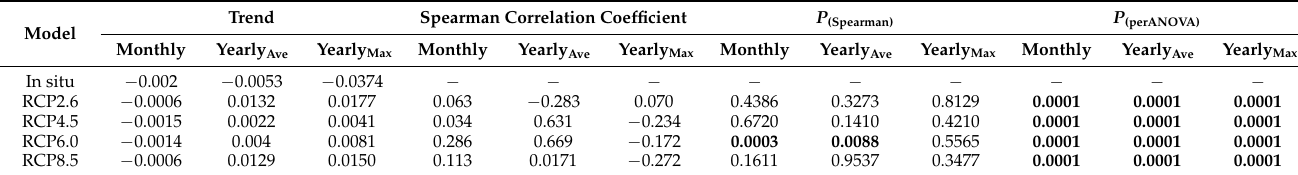
Table 1. Temperature trends from 2006 to 2019 at Nine-mile Reef according to each temperature model and associated temporal metric, and spearman correlation coefficients and associated probability values, as well as post hoc permutational ANOVA probability values, between in situ temperatures and the four Representative Concentration Pathway (RCP) modelled temperature timeseries. Significant differences are highlighted in bold ( α =